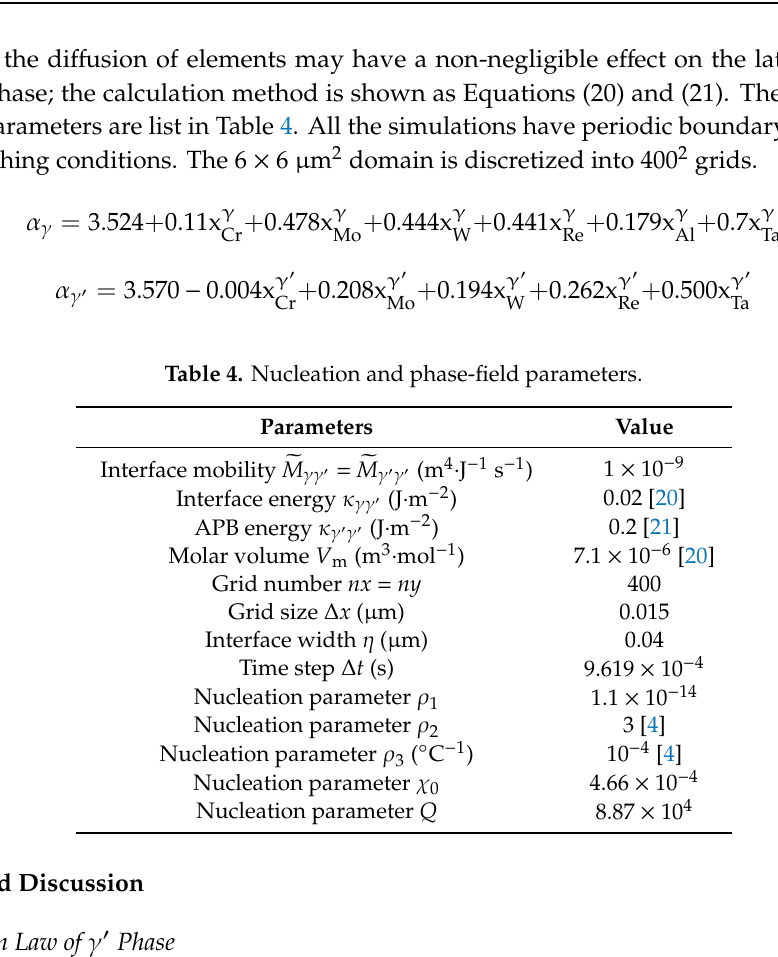
Table 3. Temperature-related elastic constants C α